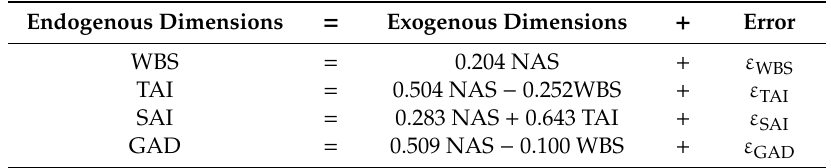
Table 15. Final path diagram for structural equations of the PANAS-GAD-7-IDATE model. Endogenous